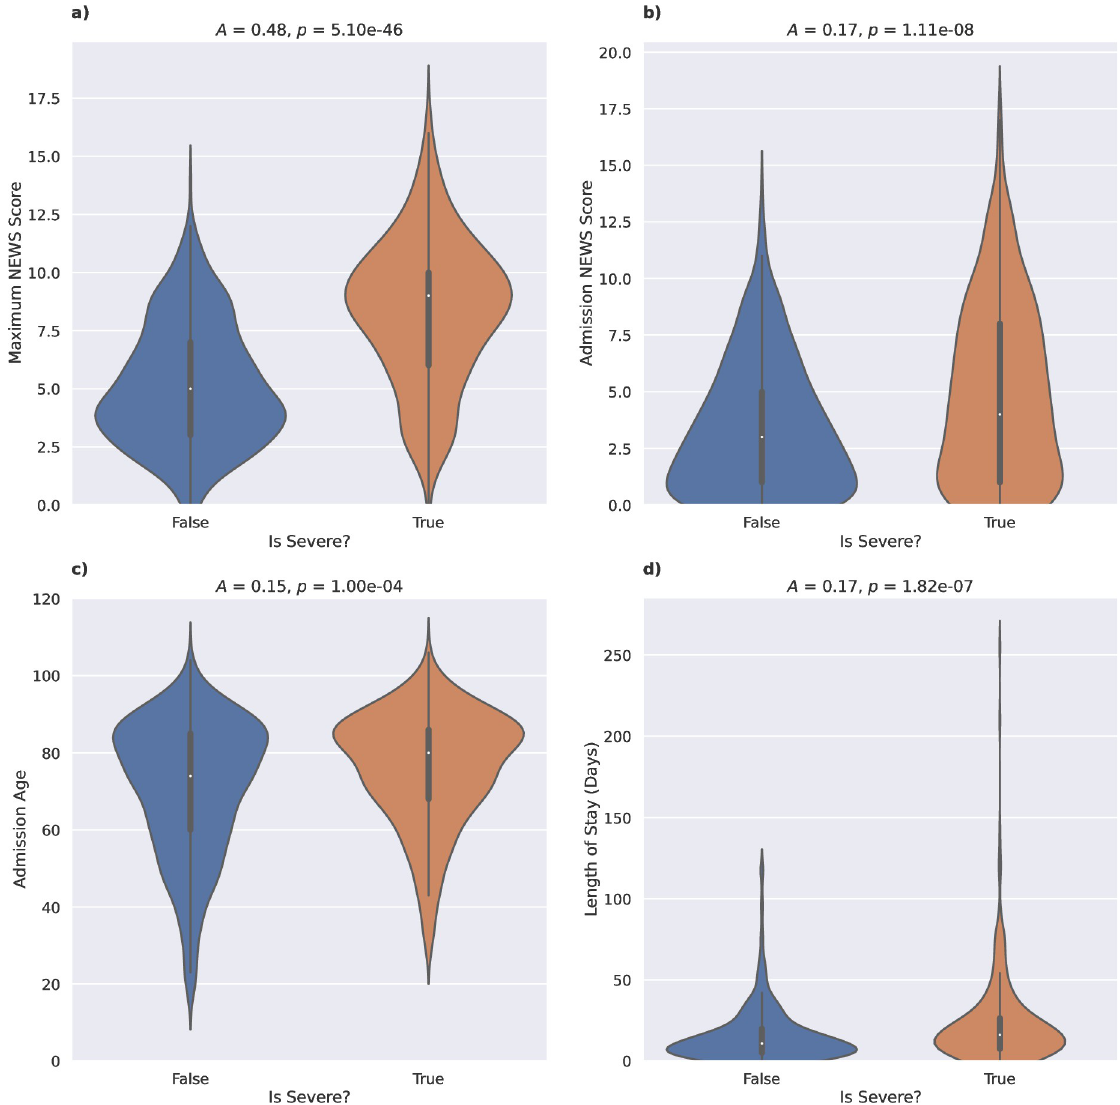
Fig 1. Association of disease severity with continuous variables. Violin plots comparing the distribution of continuous variables with statistically significant relationships with disease severity between severe cases (death, ICU admission or intubation) and non-severe cases. Variables shown are a) the maximum NEWS2 score, b) the admission NEWS2 score, c) the age at admission and d) the length of stay (days). Association strength A (based on the Correlation Ratio) and p-values p are shown above each